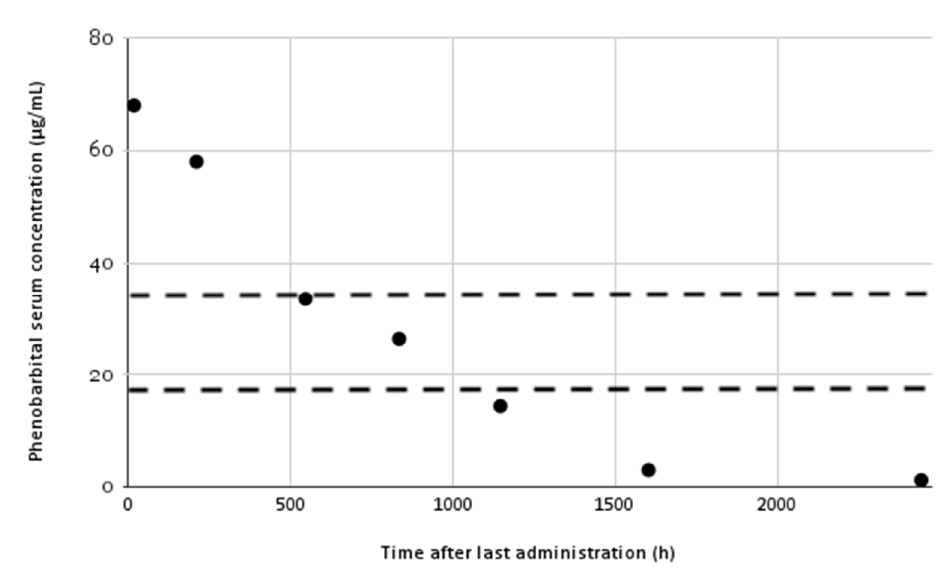
Figure 2. Observed serum phenobarbital concentrations versus time. The animal received 2.6 mg/kg PO SID PB for 35 days prior to the first time point, and no PB after that point. The dotted lines represent the proposed therapeutic range for this animal.